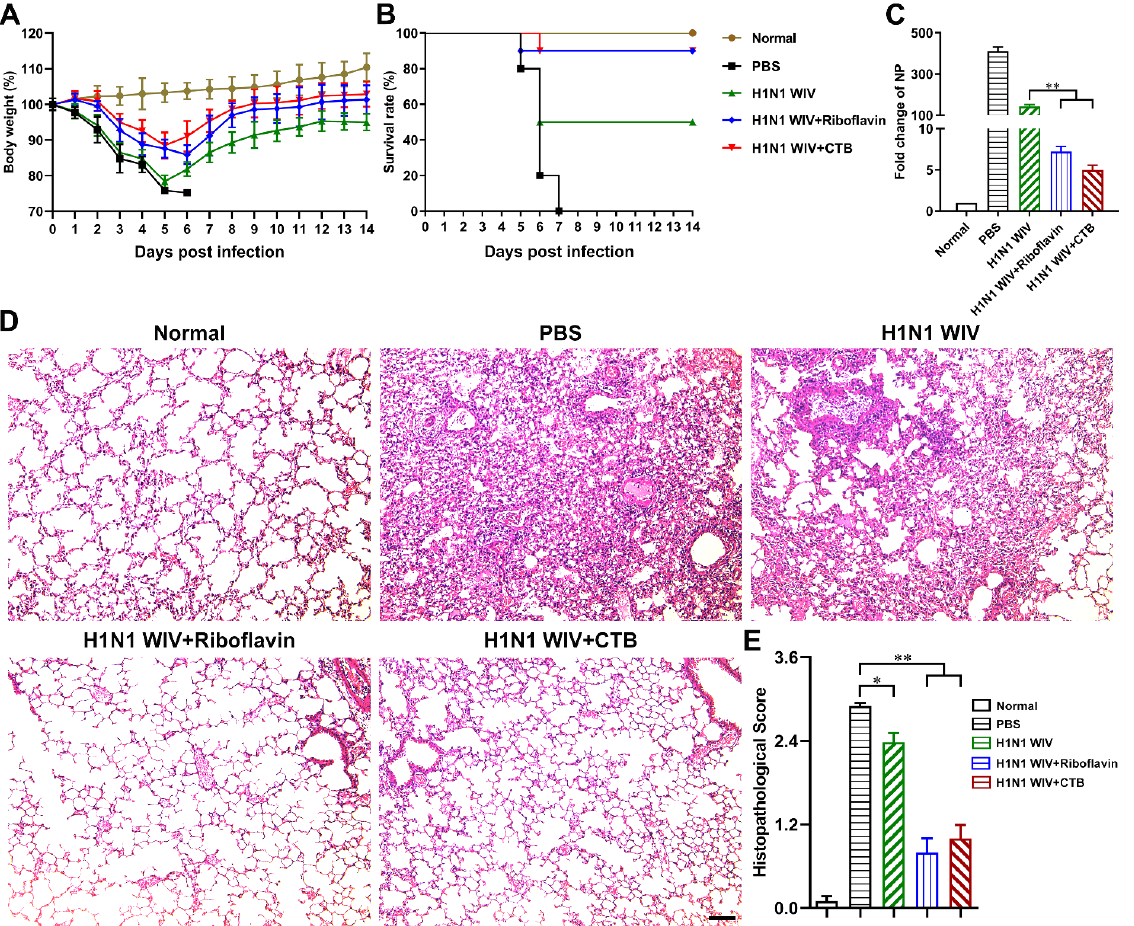
Figure 3. Intranasal vaccination with H1N1 WIV plus riboflavin protects mice from H1N1 influenza virus attack. Twenty-eight days after the primary immunization, mice were anesthetized and intranasally challenged with 10 6 EID 50 of H1N1 influenza virus. ( A , B ) The average body weights ( n = 10/group) and survival rates ( n = 10/group) in each group were